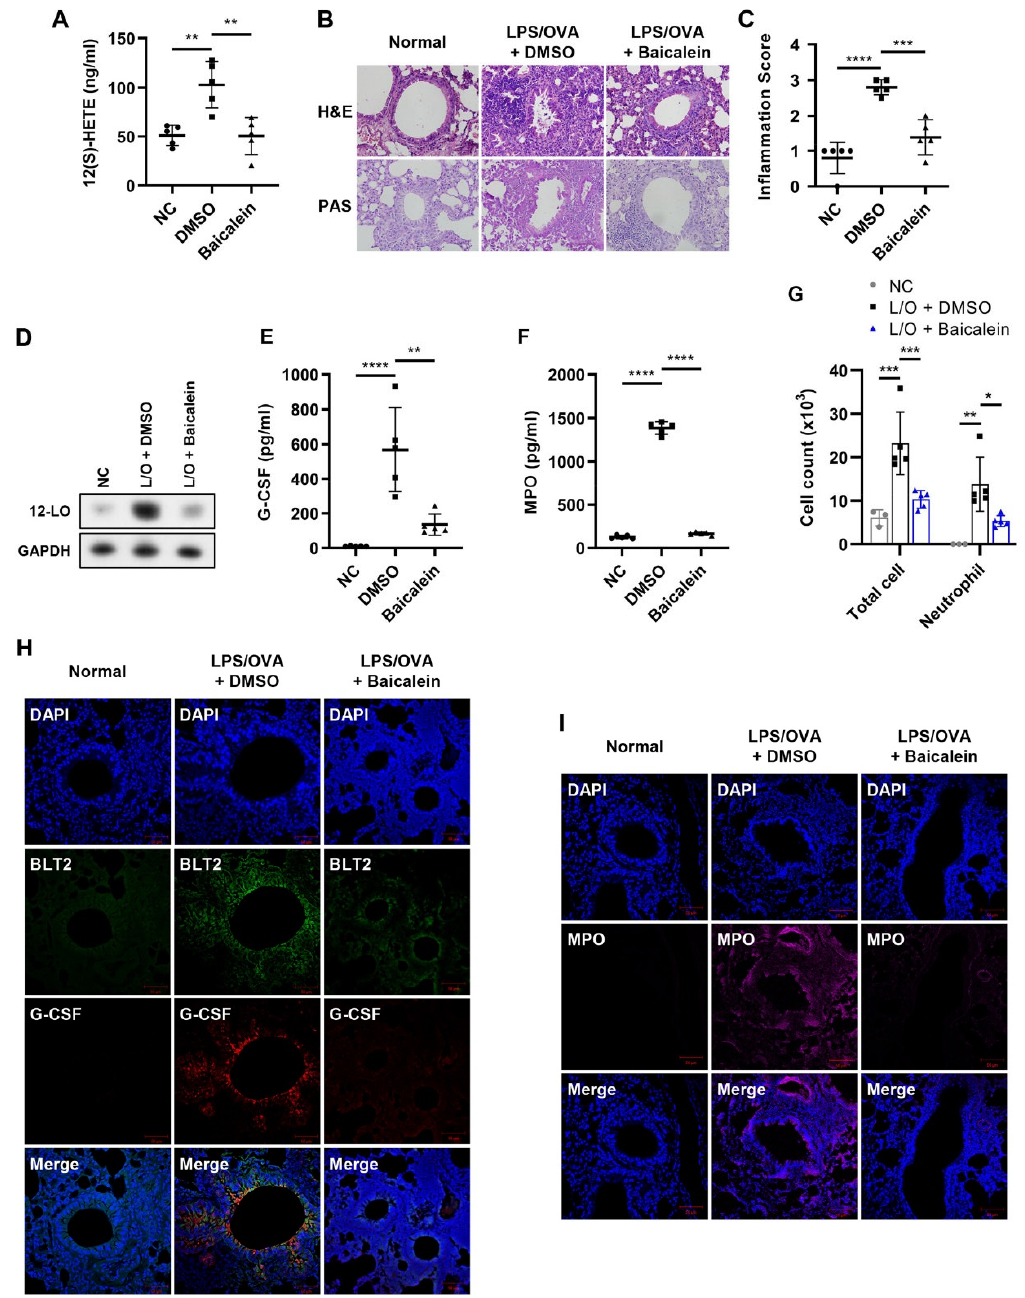
Figure 5. 12 ‐ LO is also necessary for the production of G ‐ CSF and contributes to neutrophilic airway inflammation. The 12 ‐ LO inhibitor baicalein (20 mg/kg) or DMSO was administered by i.p. injection 1 h before each challenge. The negative controls (NC) were untreated. ( A ) 12( S ) ‐ HETE levels in BALF were analyzed by ELISA. ( B , C ) H&E and PAS staining of mice lung tissues. Perivascular and peribronchial inflammation in addition to mucus secretion, was examined and scored (400×). Inflammation scores are shown as the mean ± SD ( n = 5 per group). ( D ) Mouse lung tissue was homogenized, and the protein was isolated to assess the level of 12 ‐ LO by Western blotting. ( E , F ) G ‐ CSF and MPO levels in BALF were analyzed by ELISA. ( G ) The number of immune cells in BALF was estimated using a CytoSpin and staining with Diff ‐ Quik. The results are shown as the mean ± SD ( n = 5 per group). ( H , I ) IF staining of mice lung tissue for BLT2 (green, Alexa Flour 488), G ‐ CSF (red, Alexa Flour 647), and MPO (magenta, Alexa Flour 594). Nuclei were counterstained with DAPI (blue; 400×). The IF images are representatives of three independent trials with similar results. All experiments were performed in triplicate. * p < 0.05, ** p < 0.01, *** p < 0.001, **** p < 0.0001 versus each control group.